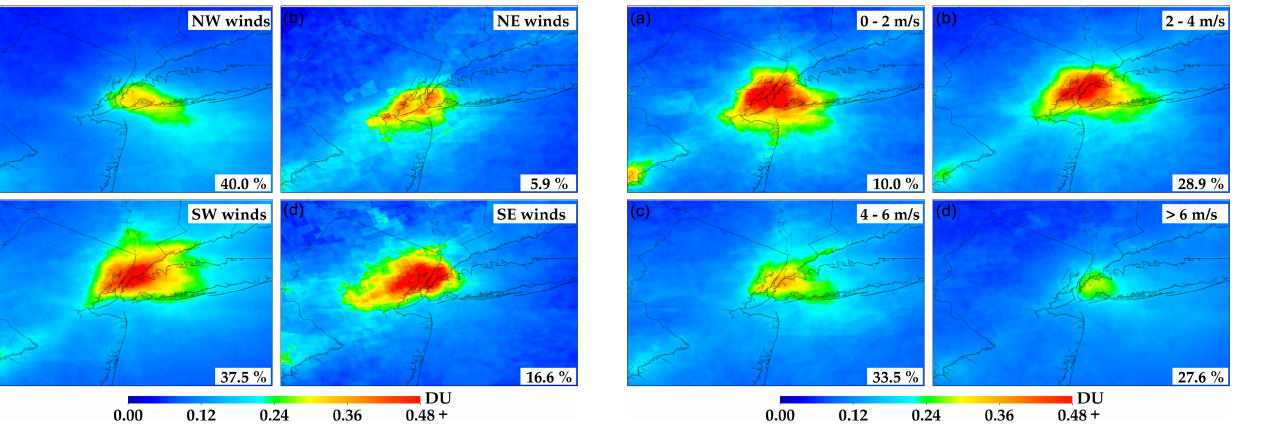
Figure 12. TROPOMI NO 2 (May 2018–December 2019) seg- regated by 100m wind speed in 2ms − 1 intervals from ERA5 daily meteorology. The percentages of each wind-speed interval are shown at the bottom right corner of each